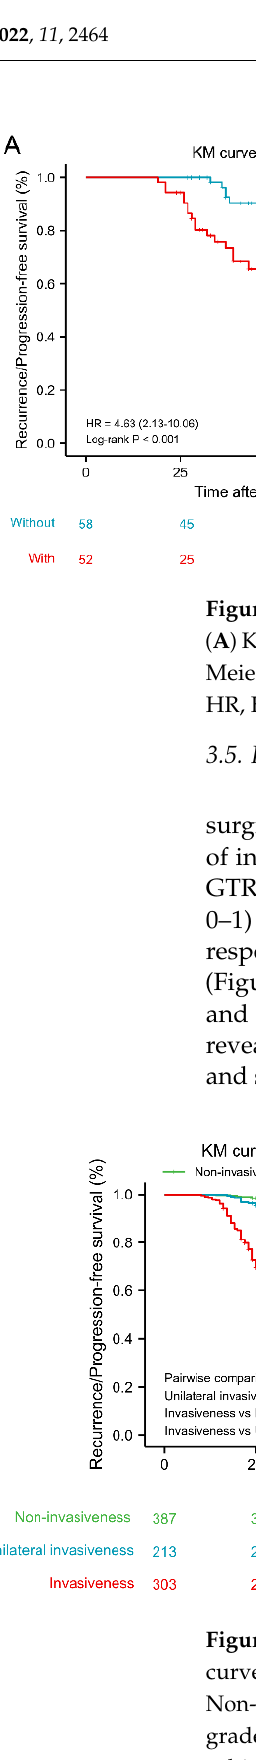
Figure 5. Bar chart illustrating the gross-total resection (GTR) rates of Knosp grade 2–3 with or without surgical invasiveness. SI: surgical invasiveness. ** p < 0.01.